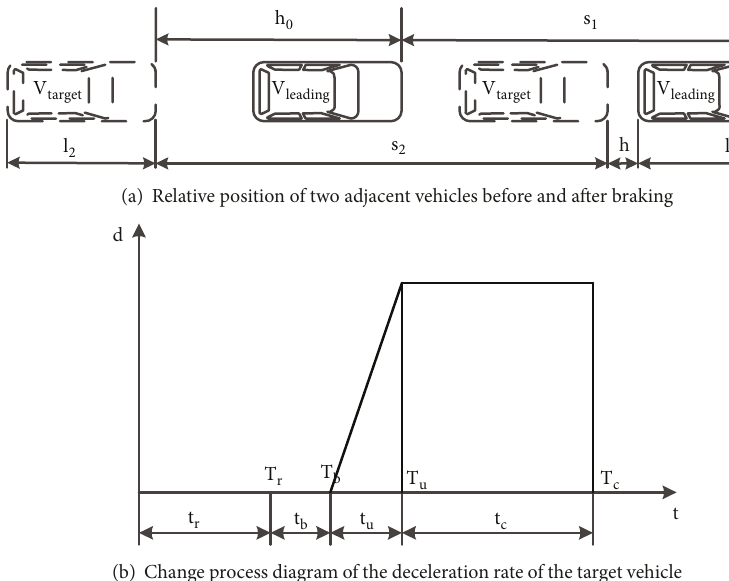
Figure 3: The process of